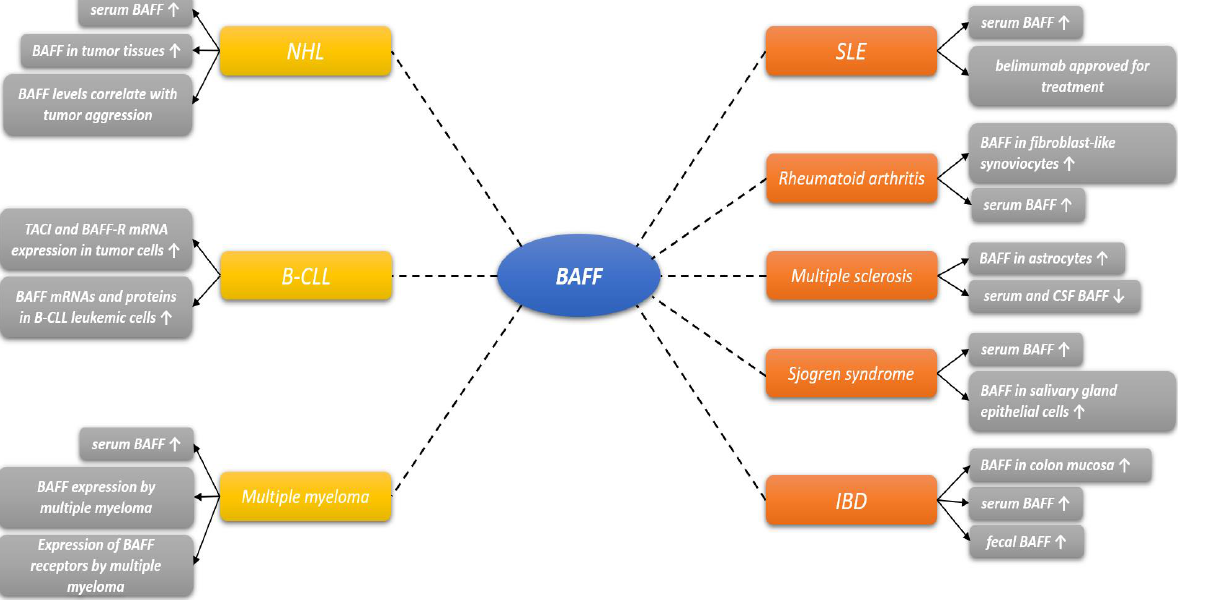
Figure 2. Involvement of BAFF in various diseases. Abbreviations: BAFF-R: B-cell activating factor receptor; BCMA: B cell maturation antigen; TACI: transmembrane activator and calcium-modulating and cyclophilin ligand interactor; CSF: cerebrospinal fluid; NHL: non-Hodgkin lymphoma; B-CLL: B-Cell chronic lymphocytic leukemia; IBD: inflammatory bowel disease.